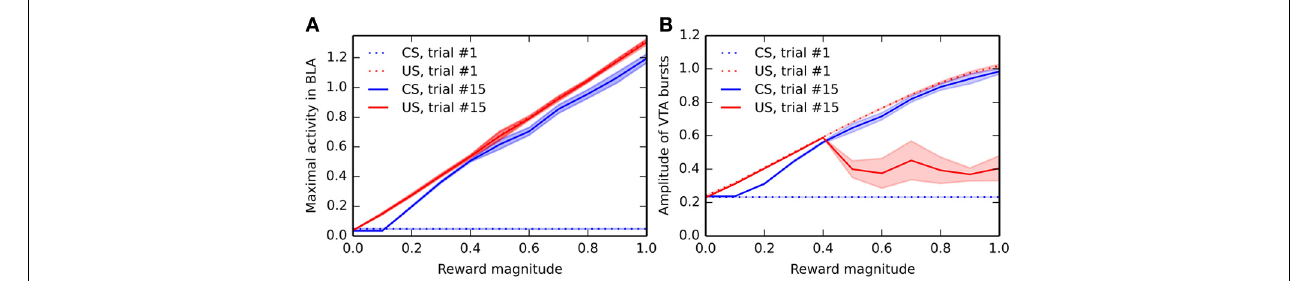
FIGURE 7 | Dependency of the activity in BLA and VTA on reward magnitude. Panel (A) shows the maximal firing rate in BLA around CS-onset and reward delivery during the first and last trial of conditioning, for different reward magnitudes. For each value of the reward magnitude, the CS1-US1 association is presented 15 times, and the maximal activity in BLA around CS-onset (between 900 and 1100ms after the start of each trial) and reward delivery(between3900and4100msafterthestartofthetrial)isrecorded.The experiment is repeated 10 times (without different initial values), and the mean (solid line) and standard deviation (colored area) of these measurements are plotted. The blue dotted line shows the maximal activity at CS-onset during the firsttrial,whichdoesnotdependonrewardmagnitude,asnolearninghastaken place yet. The red dotted line shows the maximal activity at reward delivery during the first trial, which is proportional to the reward magnitude because of learning in the LH → BLA projection during the sensitization phase. For the last